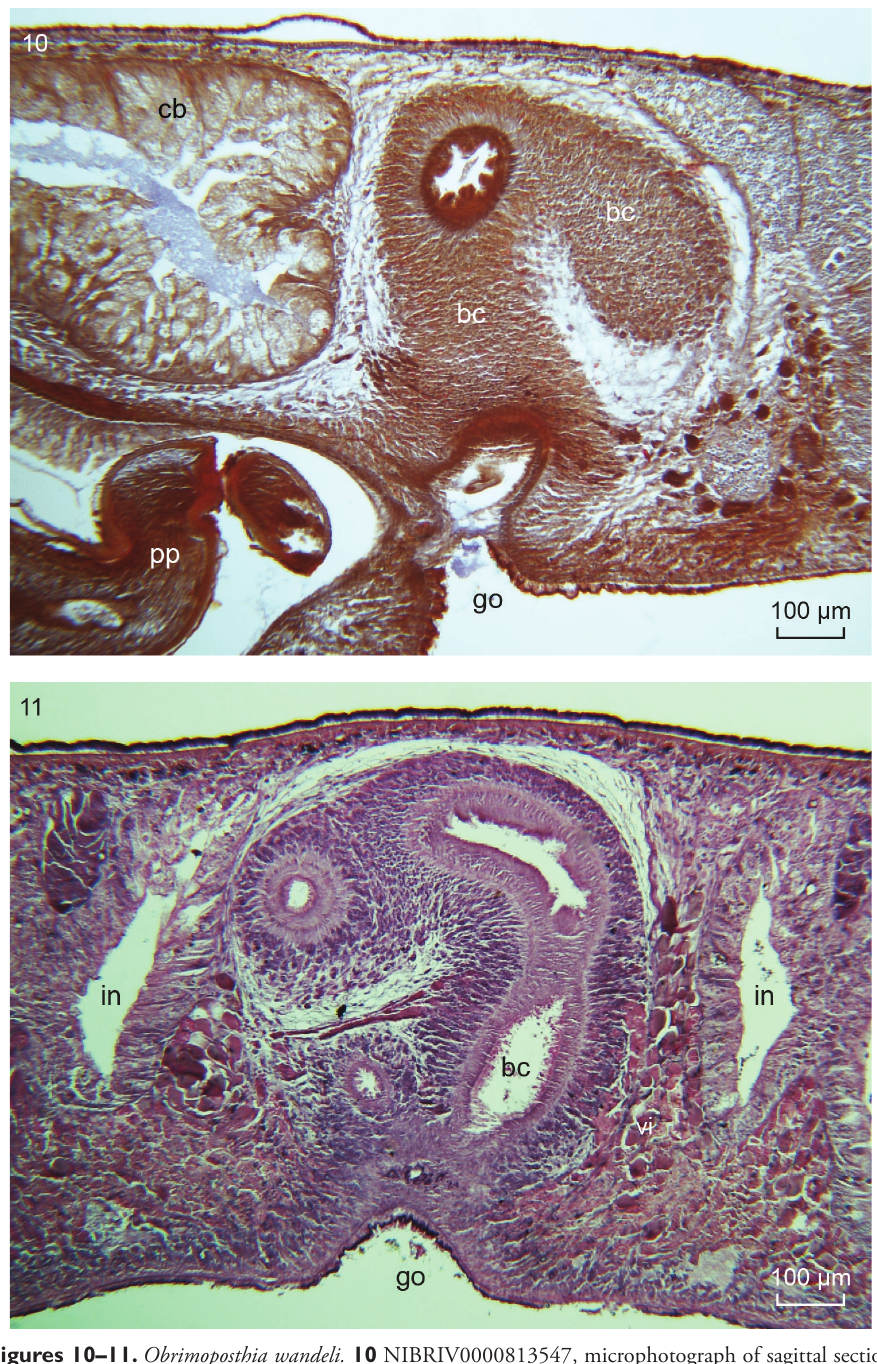
of the copulatory apparatus; anterior to the left 11 ZMA V.Pl. 951.5, microphotograph of transverse sec- tion through the bursal canal and